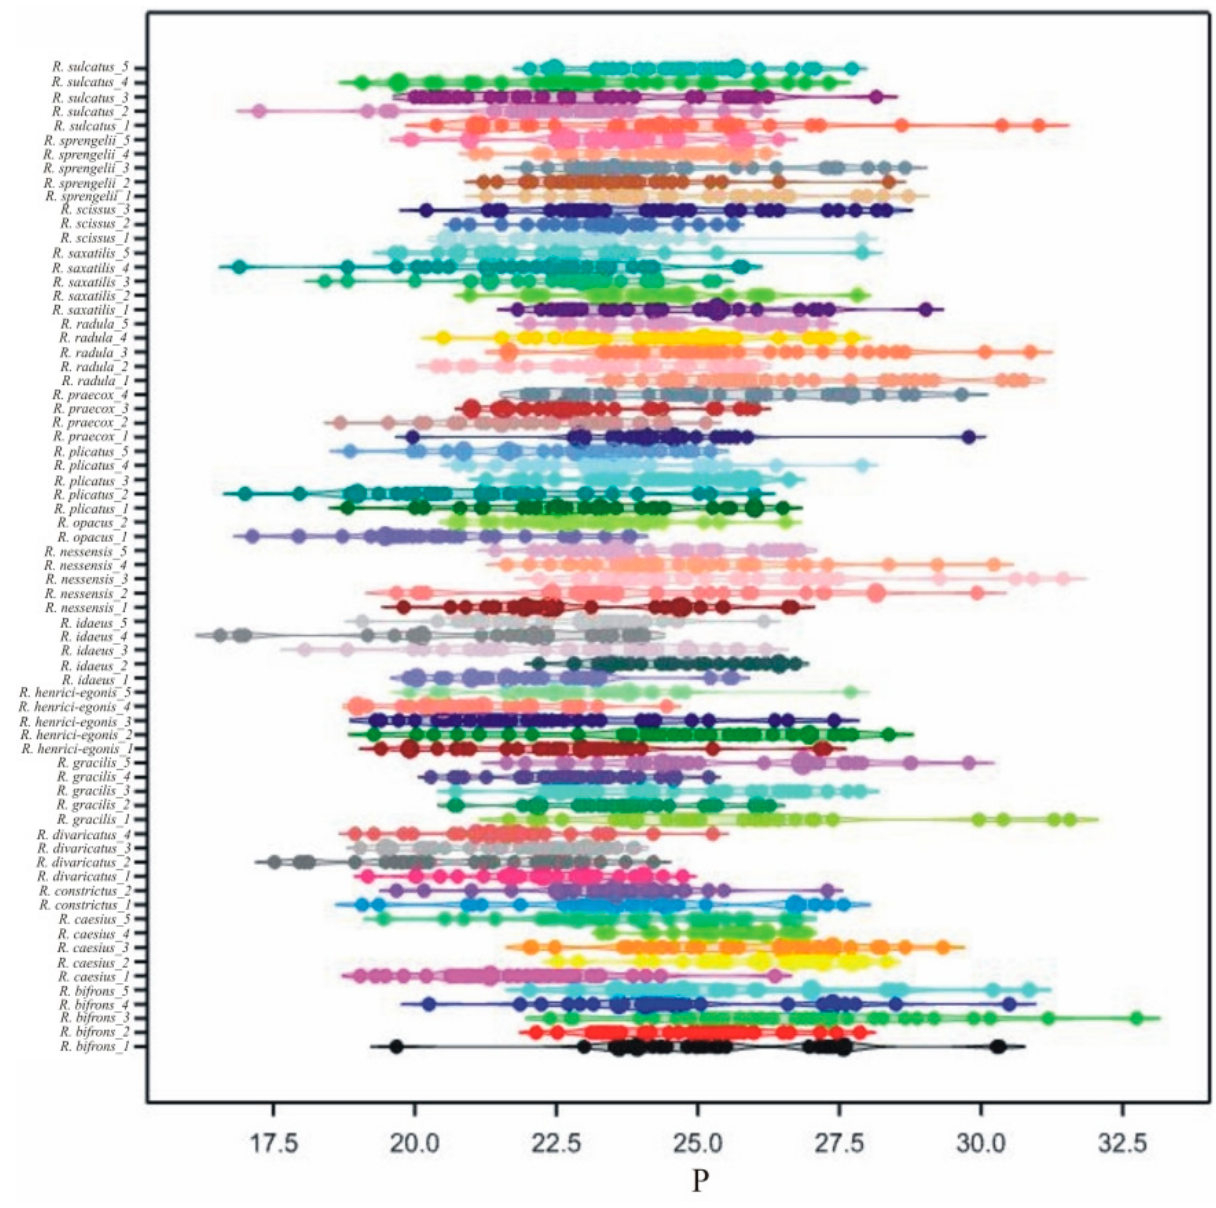
Figure 1. The density plot of P trait for Rubus species. The point “ • ” indicates trait observation for individual species.